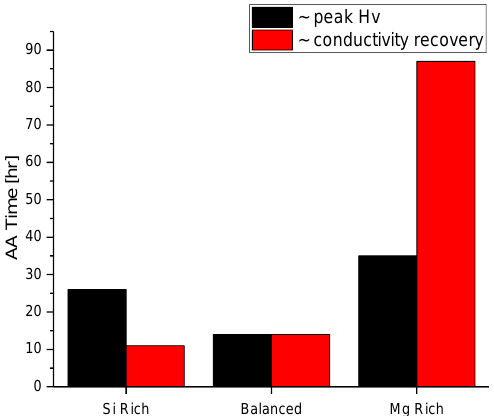
Figure 18. Comparison of AA times associated with peak hardness and conductivity recovery (of 4 h compared to 0.5 h prior NA conditions) for all high strength compositions in the AC condition (comparable to Figure 16, in the WQ condition). Note that the peak Hv time does not necessarily indicate a hardness recovery (i.e., Mg-rich alloy). AA times are judged by eye, so error bars are not included.